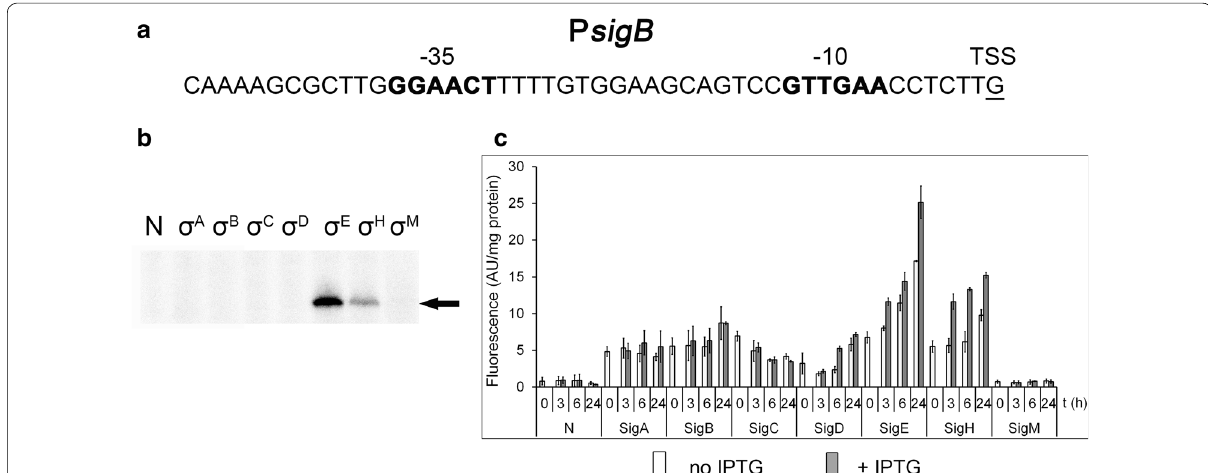
Fig. 3 Assignment of sigma factors to the P sigB promoter. a Sequence of the P sigB promoter (Halgasova et al. 2001). The assumed sequence elements are in bold , the transcriptional start site is underlined . b In vitro transcription with P sigB as a template. Individual sigma factors associated with RNAP are shown at the top . N no sigma factor protein was added to the RNAP core. The specific transcripts are indicated with an arrow . c P sigB promoter activity determined using the two-plasmid C. glutamicum ∆ sigH by measuring the fluorescence intensity of the Gfpuv reporter. The sigma factors whose genes were overexpressed are indicated at the bottom . IPTG was added at time 0. AU arbitrary units. The SDs of three measurements are depicted as error